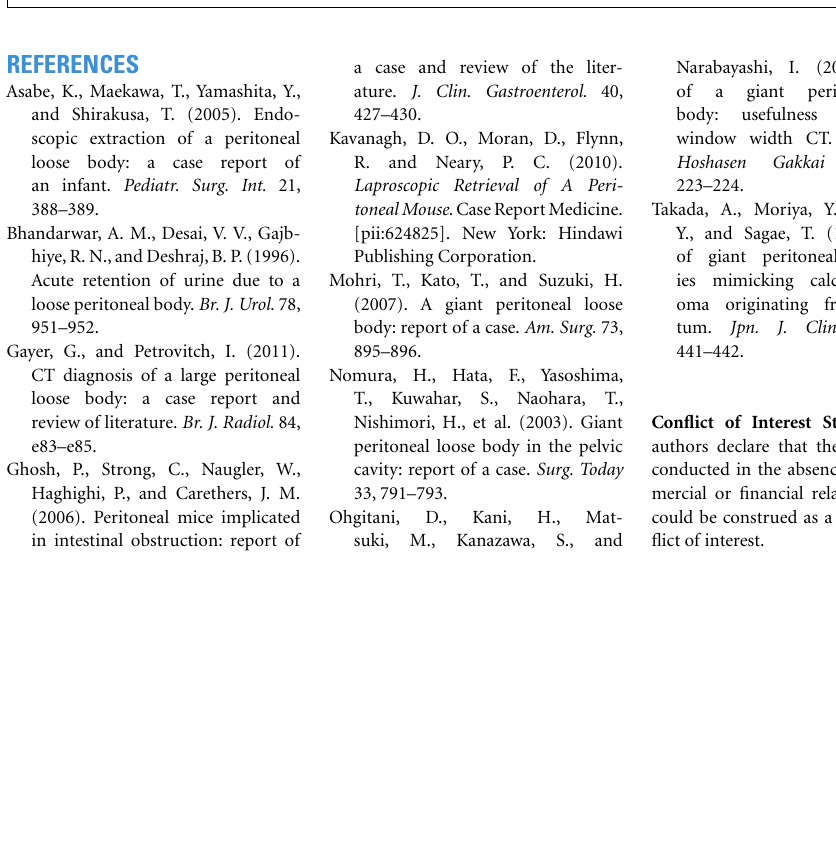
FIGURE 2 | PET/CT images demonstrate the soft tissue lesion has moved from the right to left hemipelvis (arrow) on low dose CT (left). The lesion demonstrated no metabolic activity on PET (center) and fused image